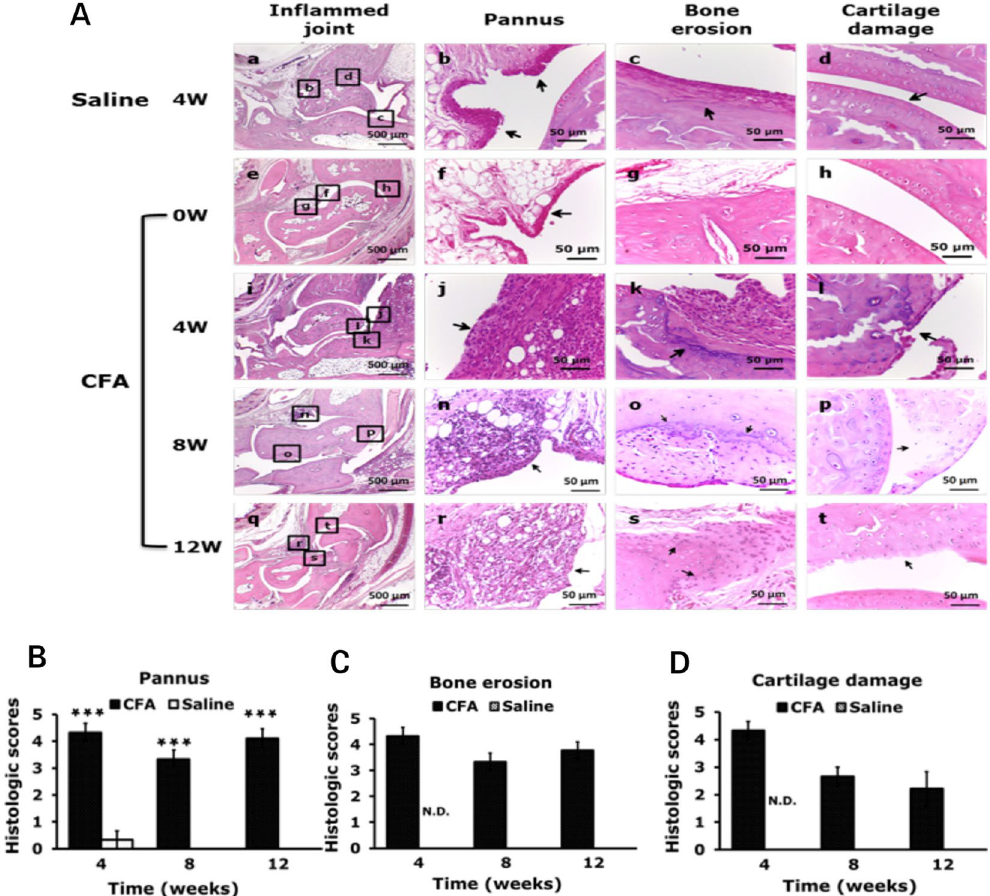
pannus ( B ), bone erosion ( C ), and cartilage damage ( D ). *** p < 0.001, compared with 4-week